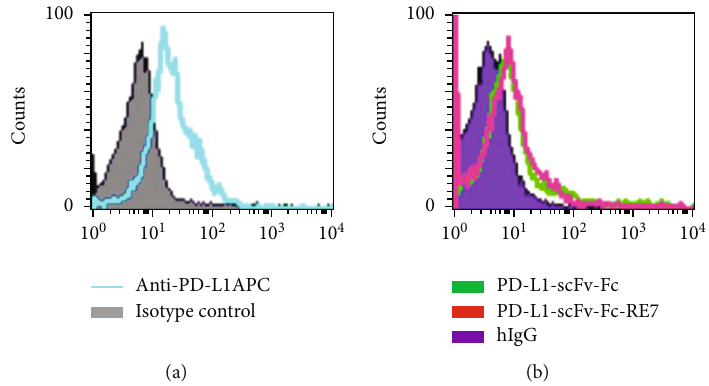
Figure 2: Characterization of the binding of PD-L1-scFv-Fc and PD-L1-scFv-Fc-RE7 to ID8-luc tumor cells using fl ow cytometry. (a) Representative fl ow cytometry analysis of commercial antibody bound to PD-L1 (blue clear histogram) or isotype control (shaded histogram). (b) Representative fl ow cytometry analysis of PDL1-SCFV (green), PDL1-SCFV-RE7 (red), or isotype control (purple shaded